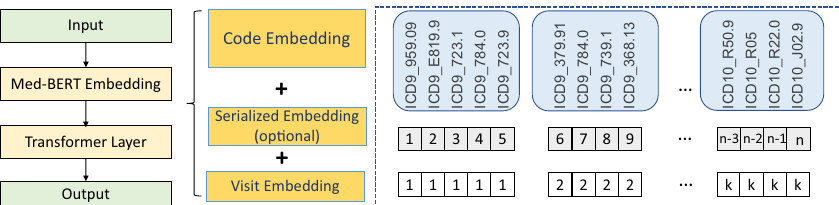
Fig. 3 Med-BERT structure. The left part is a scheme of the overall Med-BERT architecture, the middle part details the individual components of the Med-BERT embedding layer, and the right part is an example of EHR data used in each embedding